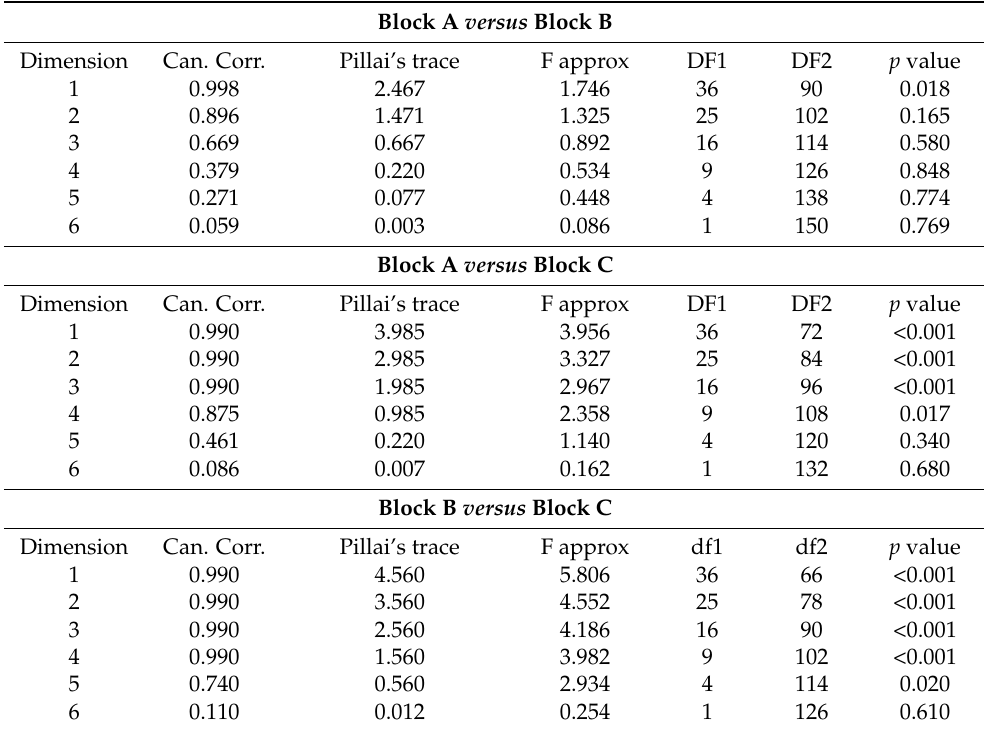
Table 5. Results of the Canonical Correlation Analysis when Comparing by Pairs the Blocks of Measurements Performed in the Control